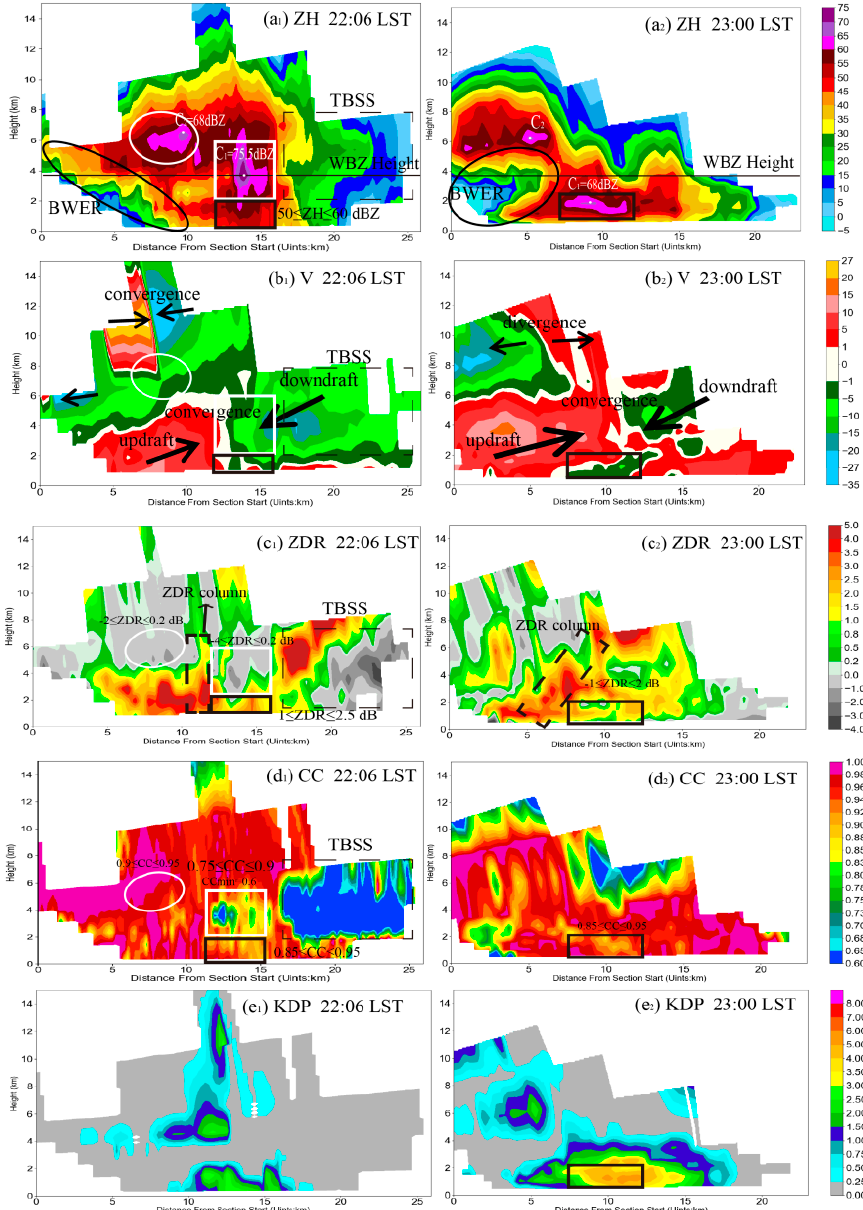
Figure 8. Vertical cross-sections along the black lines given in Figure 5d,e. ( a1 , a2 ) ZH (units: dBZ),( b1 , b2 ) radial velocity (units: m·s -1 ), ( c1 , c2 ) ZDR (units: dB), ( d1 , d2 ) CC, and ( e1 , e2 ) KDP (units: °/km) observed by Yangjiang radar. Left column, 22:06 LST; right column, 23:00 LST. Vertical cross-sections along the red lines are given in Figure 5d,e. The radial velocity observed by Yangjiang radar at 22:06 (left column) LST and at 23:00 (right column) LST. The left of each figure is the southern end of the cross section.